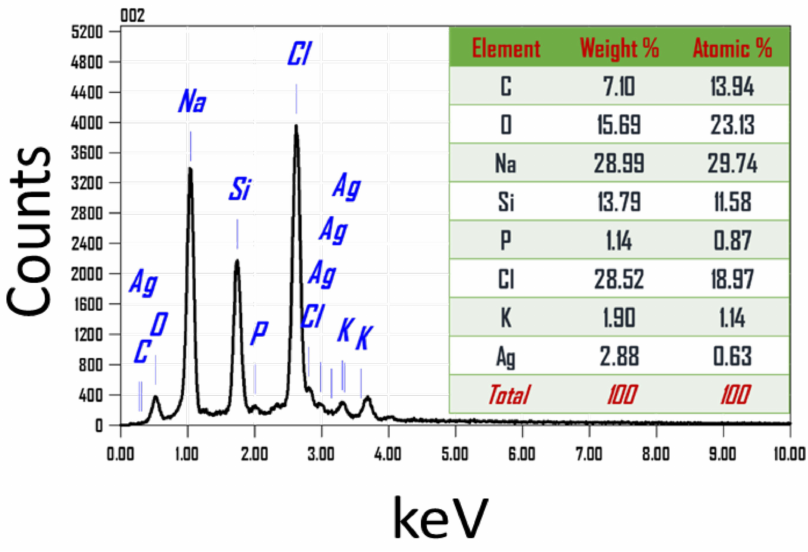
Figure 7. EDX chart of biosynthesized Ag-based NPs using bio-waste of B. cereus culturing. The DLS size was measured in Figure 8 with an average size of 238.8 nm, a polydis- persity index (PDI) of 0.47, and a zeta potential of − 19.5 mV. These results indicate that the